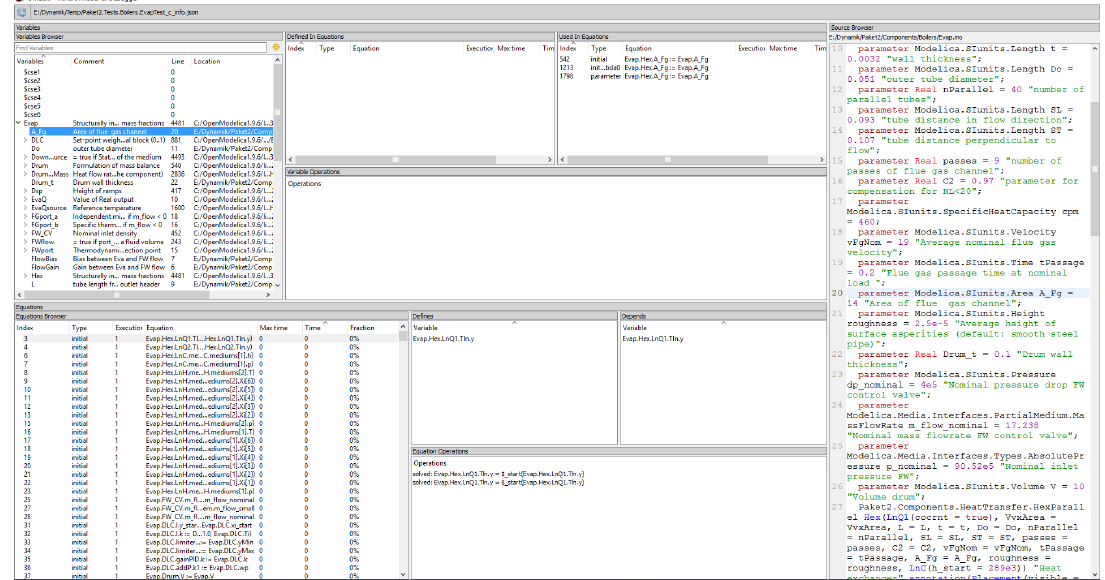
Figure 11: Transformational debugger and pro(cid:28)ling